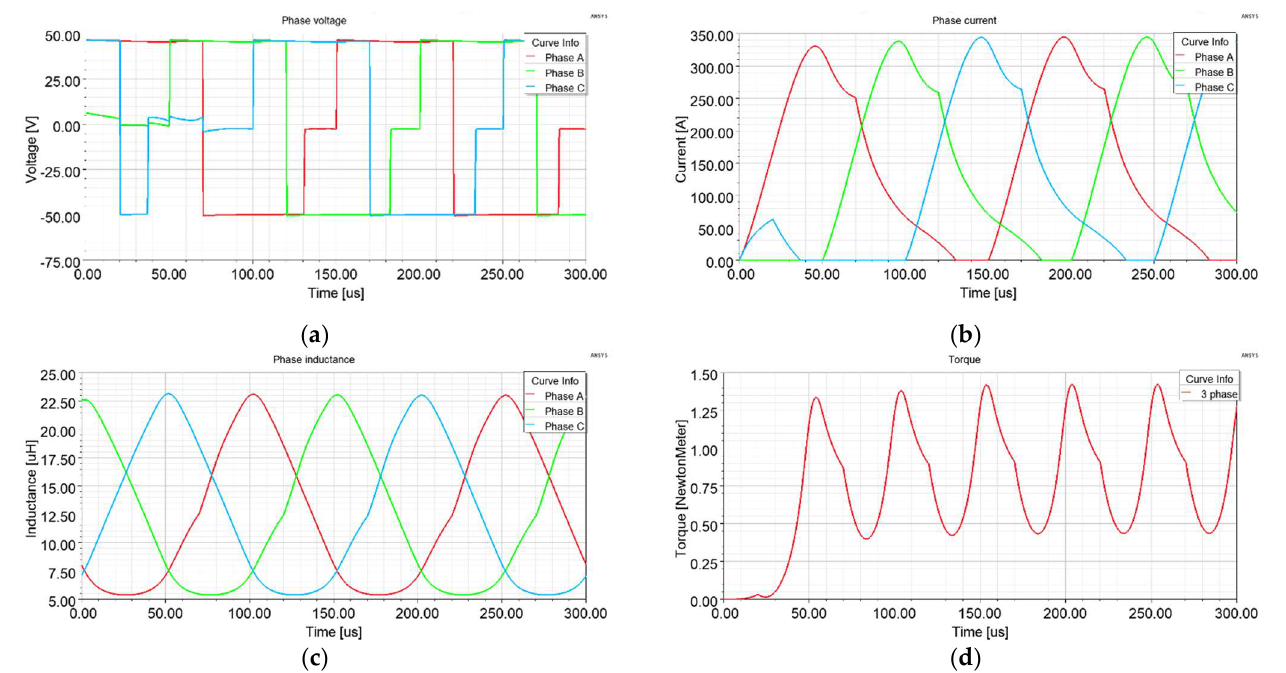
Figure 14. Dynamic parameters of the high-speed SRM at the rated speed: ( a ) phase voltage; ( b ) phase current; ( c ) phase inductance; ( d ) torque of all three phases.